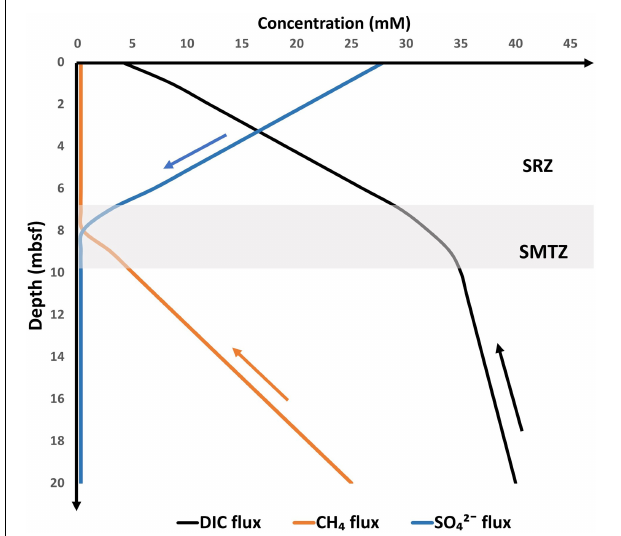
FIGURE 2 | Schematic concentration (based on measured and modeled) profiles for CH 4 , SO 42 - , and DIC, at diffusive methane flux setting. Arrows indicate flux direction. SRZ indicates the sulfate reduction zone with dominant organoclastic sulfate reduction (OSR). The DIC concentration at the SMTZ is the result of AOM, OSR, deep-DIC input, and authigenic carbonate precipitation. Modified based on data from Snyder et al. (2007, Japan Sea), Malinverno and Pohlman (2011, IODP Site U1325, Cascadia Margin), Chatterjee et al. (2011, ODP Site 1244, Hydrate Ridge), and Wehrmann et al. (2011, IODP Site 1345, Bering